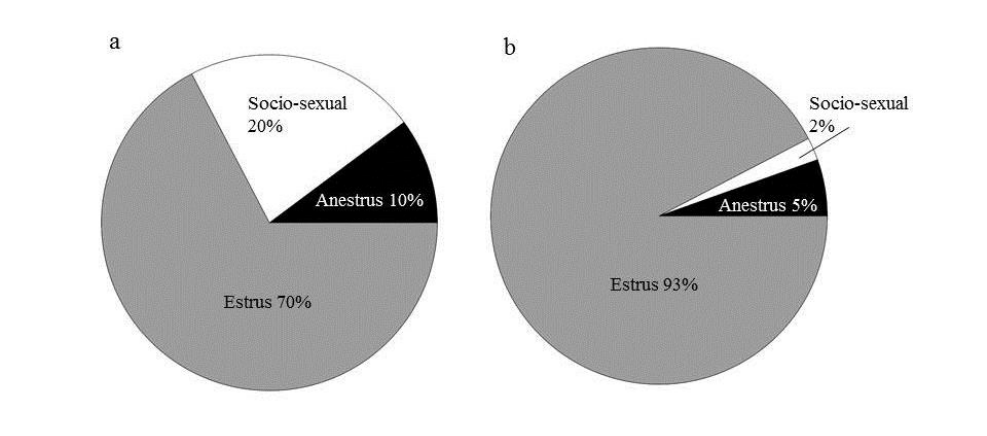
Figure 5. Percentage of reproductive behaviors during each reproductive phase for animal 1. a) active, b)